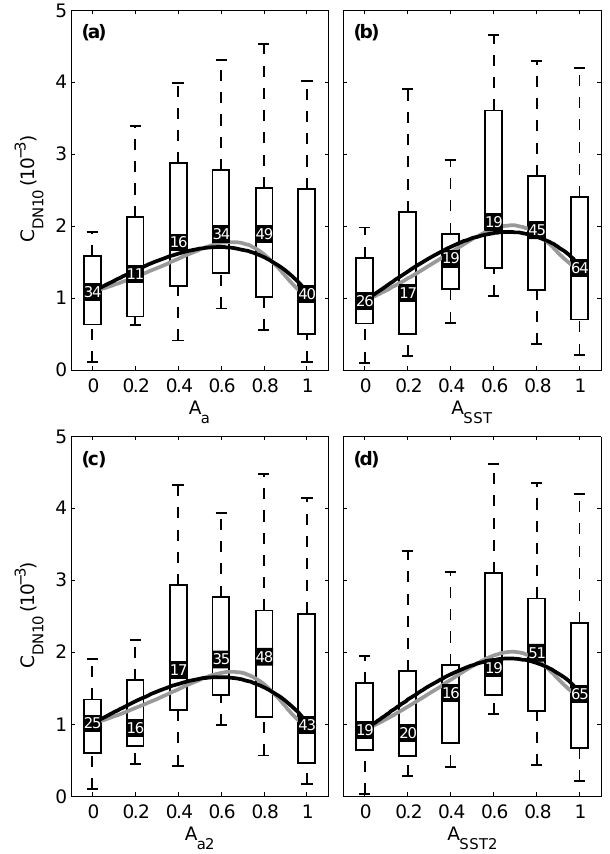
Figure 2. C DN10 as a function of ice fraction A : (a) A a (from albedo); (b) A SST (from sea surface temperature with a no ice tran- sition at − 3.4 ◦ C; (c) A a2 (from albedo with alternative tie points); and (d) A SST2 (from SST with a no ice transition at − 1.8 ◦ C). Ob- servational data are arranged in ice fraction bins of interval 0.2. Box and whisker plots show the median (black square), interquar- tile range (boxes), and 9th and 91st percentiles (whiskers) within each bin. The number of data points within each bin is indicated at the bin-median level. The L2012 scheme is illustrated by curves an- chored at our observed values for A = 0 and A = 1, using parameter settings E2016A (black curve) and E2016B (grey curve) in Table